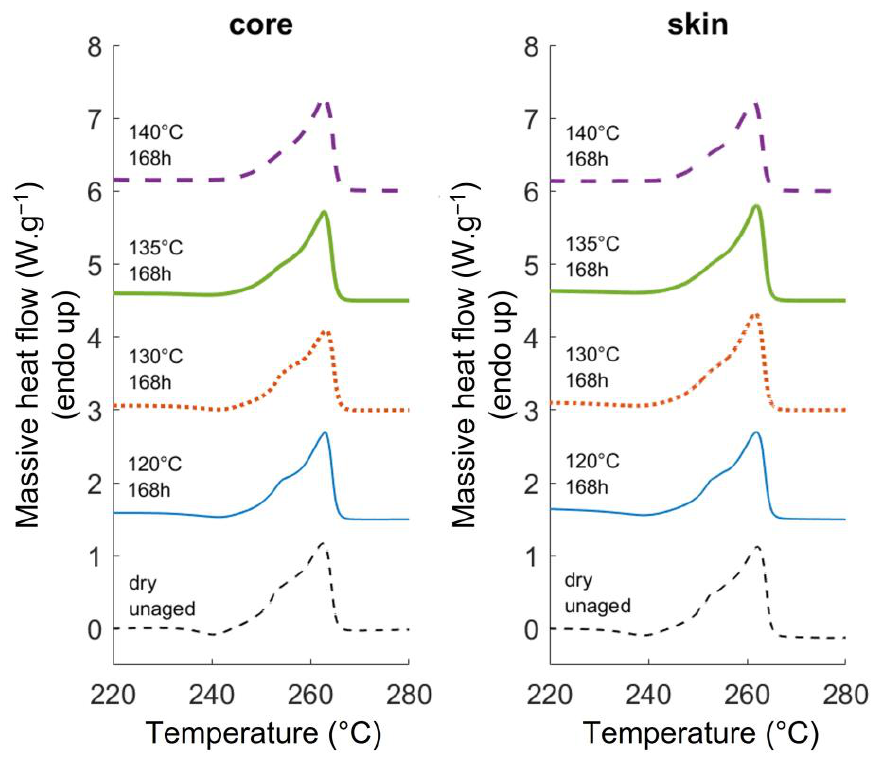
Figure 7. Typical fusion peaks of unaged and 168 h aged PA66.